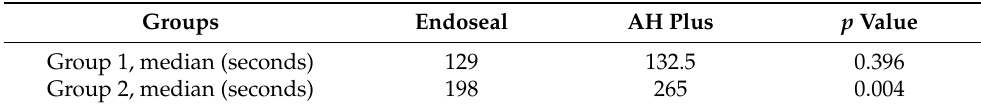
Table 2. Obturation time of groups 1 and 2. Mann–Whitney U test p value is